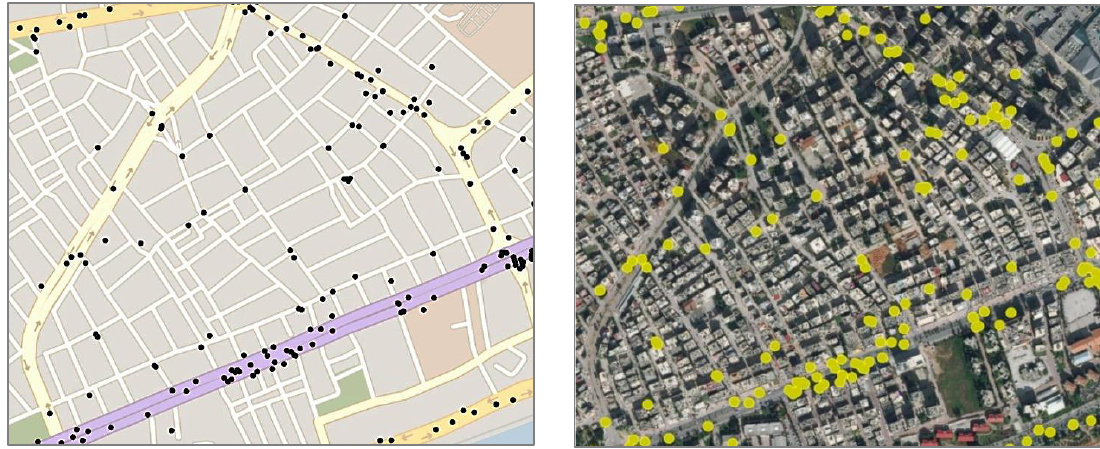
Figure 8 Street Network and Location of Accidents in Aydınlıkevler Neighborhood